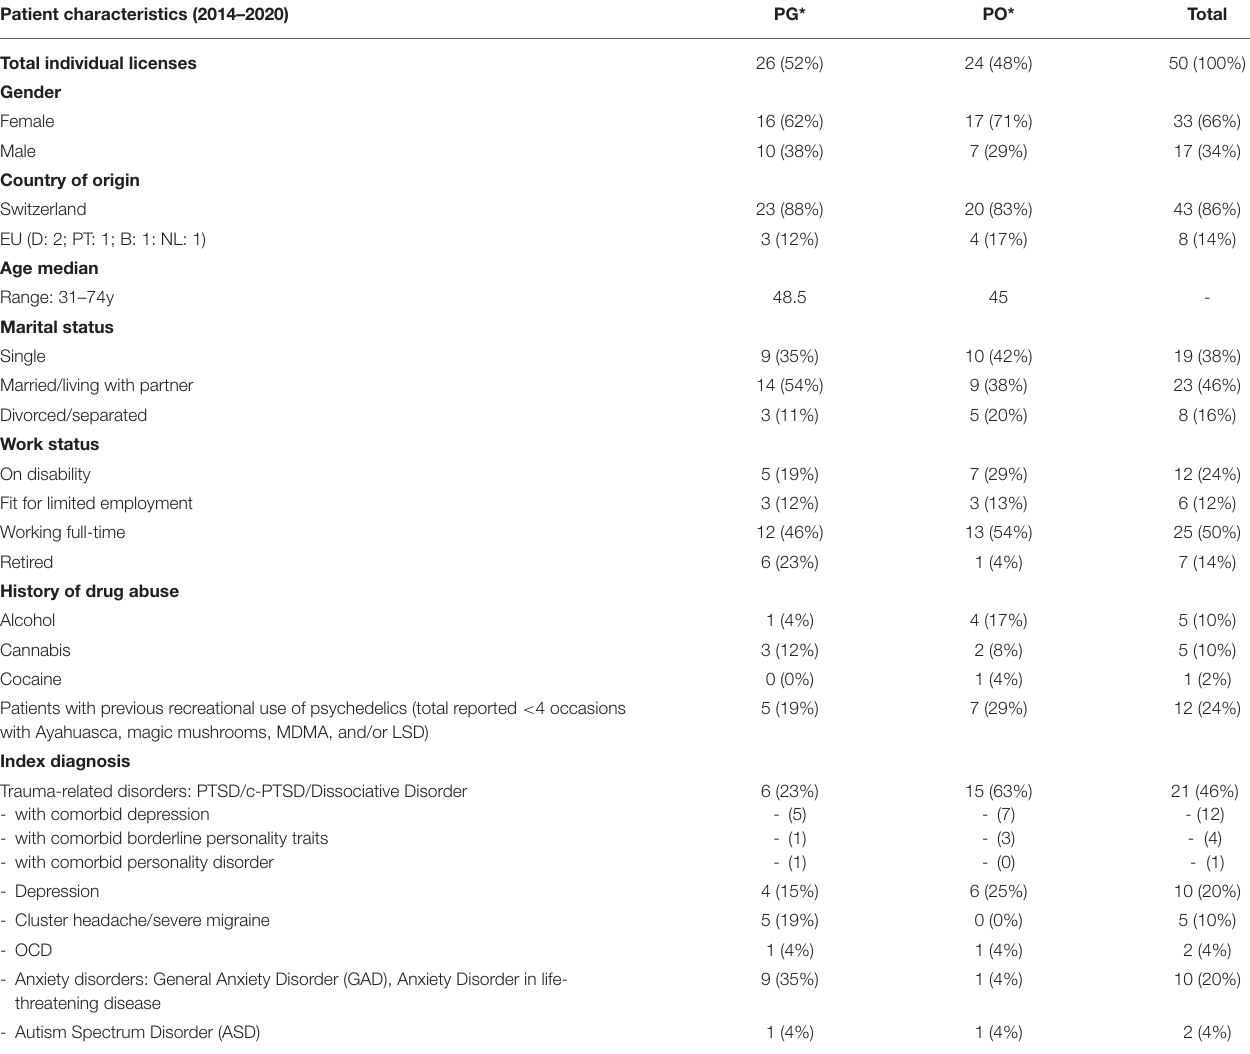
TABLE 1 | Patient characteristics and index